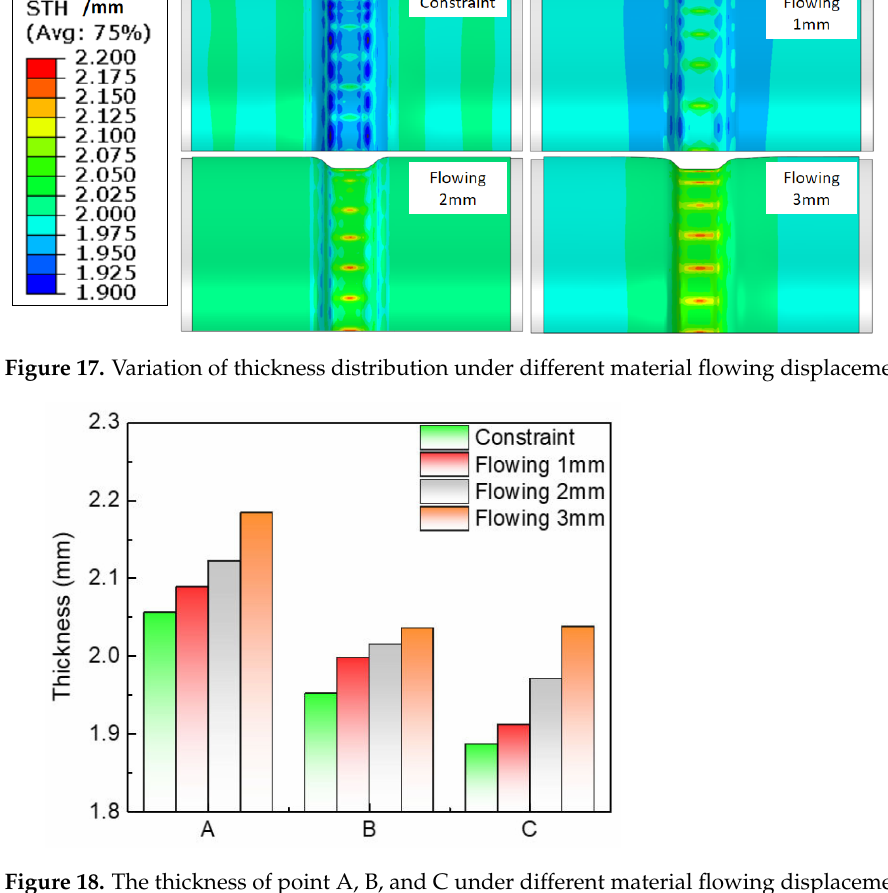
Figure 18. The thickness of point A, B, and C under different material flowing displacements.